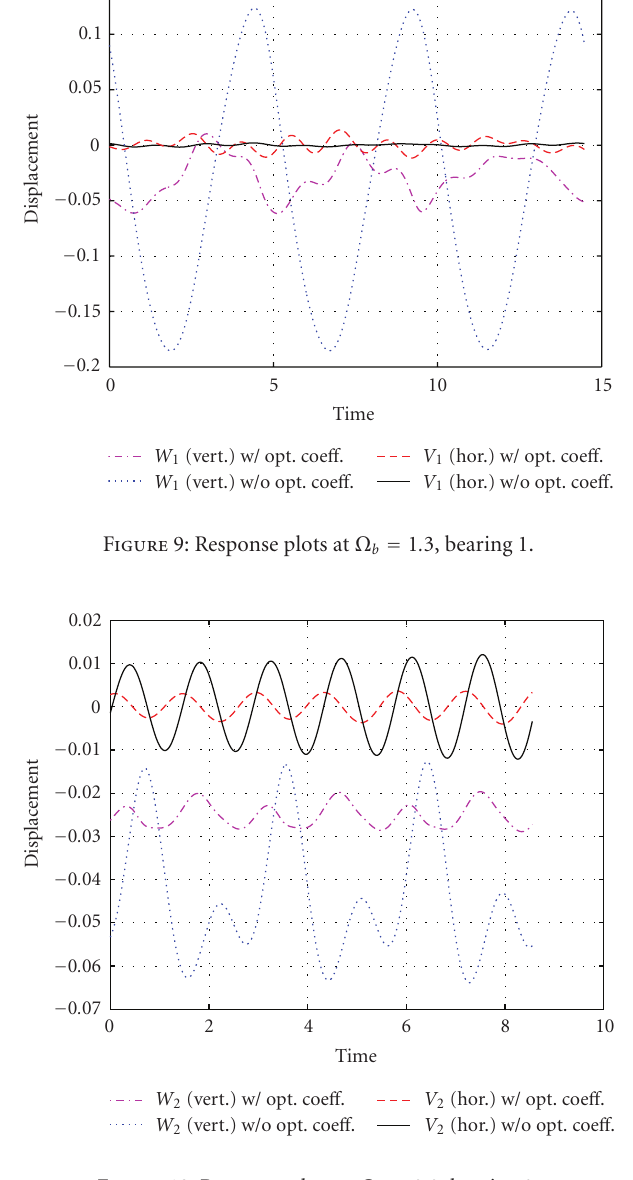
the static o ff set any larger than ten percent of the nominal gap length. The optimal control algorithm actually added amplitude to the horizontal motion. The response plot model would show no motion in the undisturbed horizontal direction prior to optimization, but as the optimization method itera- tively tried di ff erent sets of control current coe ffi cients, mo- tion was added even though the performance index was re- duced. Without a disturbance applied, the optimal solution for horizontal motion was the correction current coe ffi cients found for the linearized model. Figures 17 and 18 are plots where the horizontal motion increased by a small amount. More details of all the studies can be found in Marx